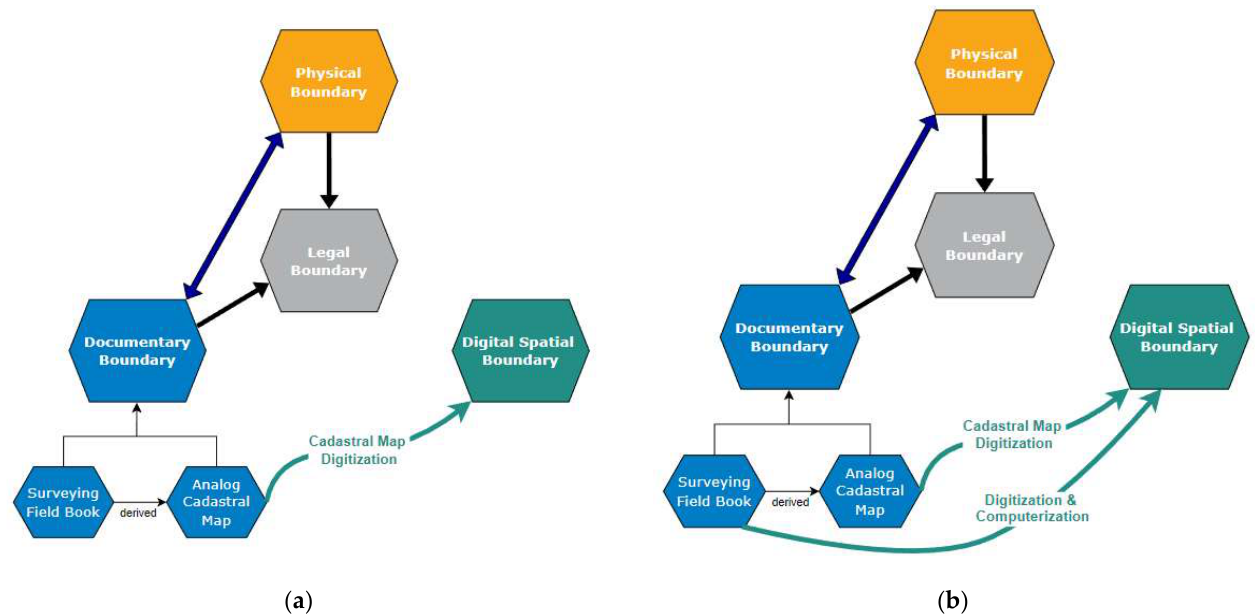
Figure 7. ( a ) The process of digitisation conducted in North Macedonia and Slovenia based on CTM; ( b ) Revised process of digitisation based on CTM by considering surveying field books.